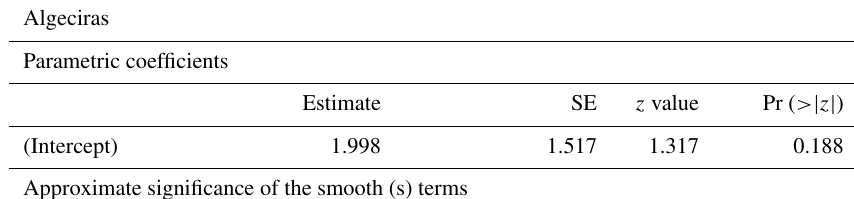
Table 3. GAM summaries for both watersheds.